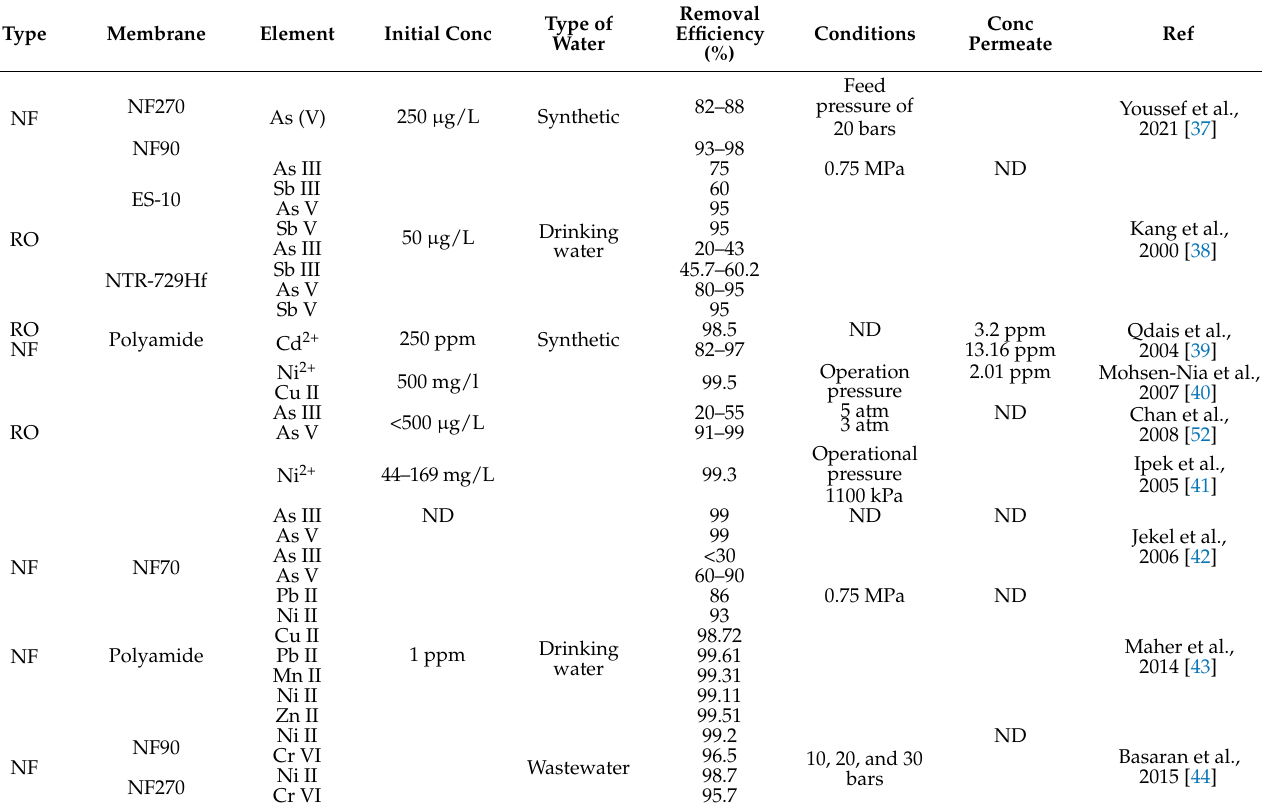
Table 6. List of key studies on heavy metal removal by using reverse osmosis and